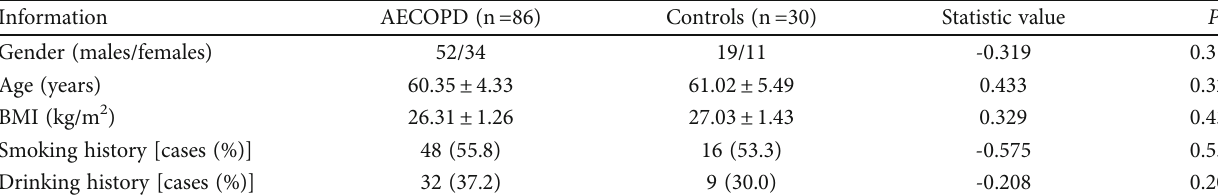
Table 1: Comparison of general